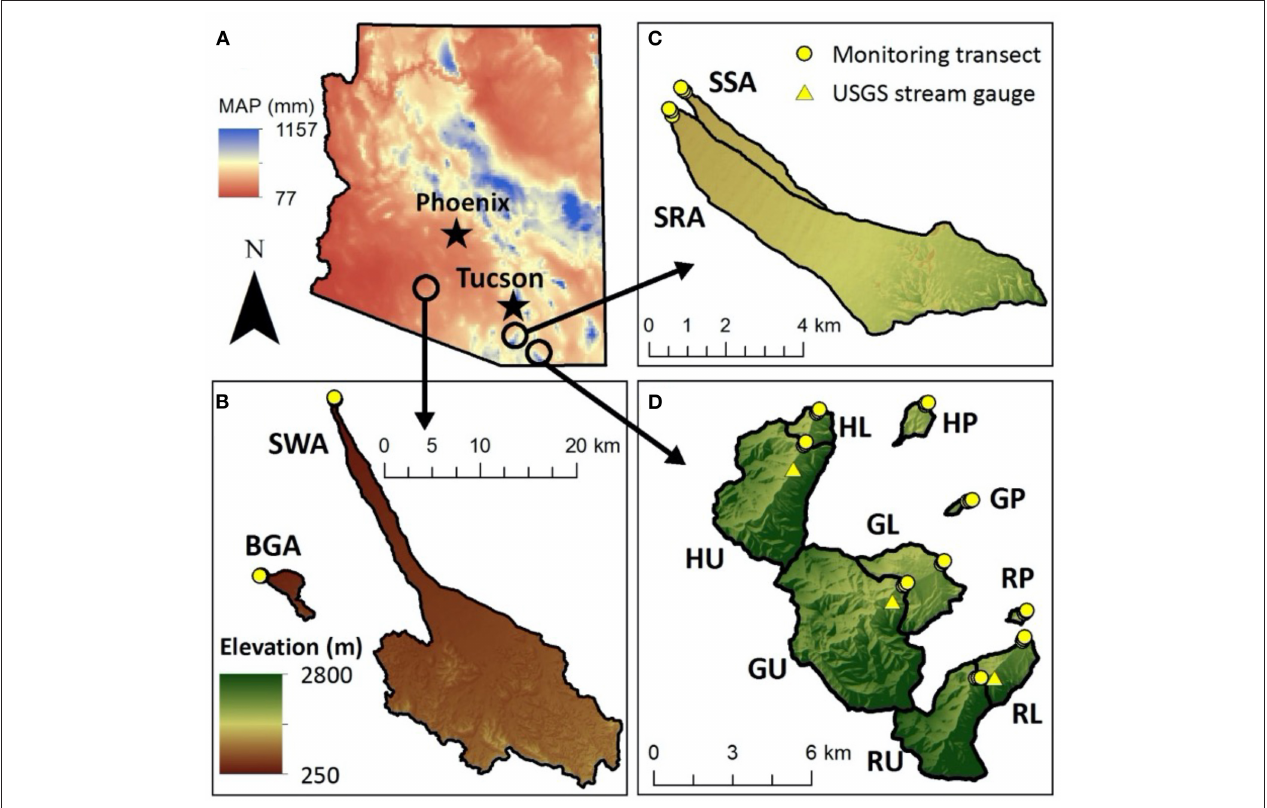
FIGURE 1 | (A) Study sites in southern Arizona across an aridity range. Sites are located at (B) the Barry Goldwater Range (SWA, BGA); (C) the Santa Rita experimental range (SRA, SSA); and (D) in the Huachuca Mountains at Huachuca Canyon (HU, HL, HP) and Garden Canyon (GU, GL, GP), located within the Ft. Huachuca Army base and Ramsey Canyon (RU, RL and